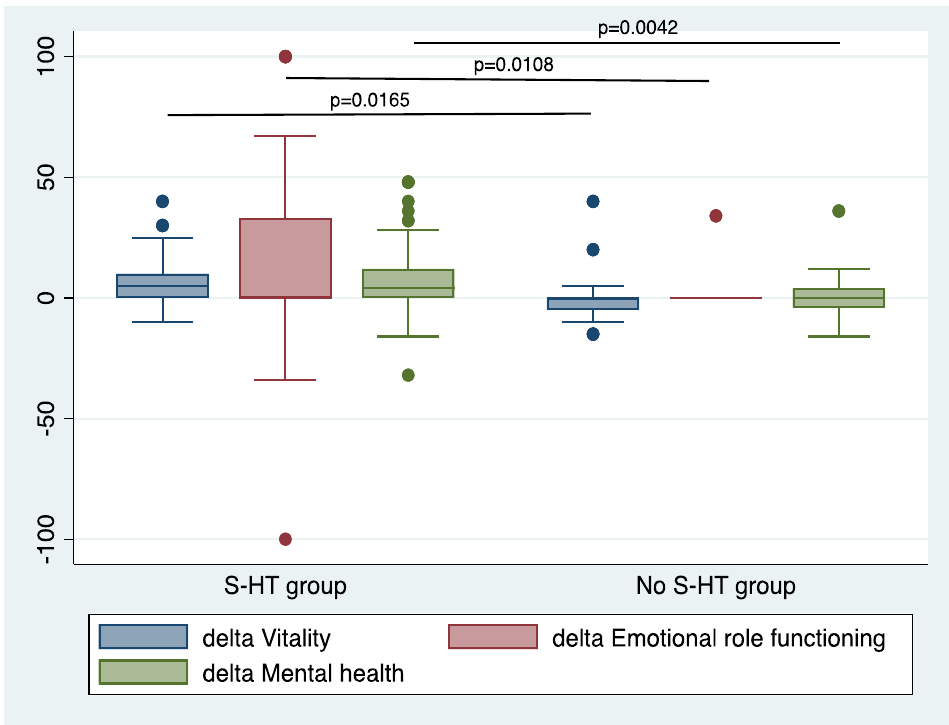
Figure 4. SF-36 Items showing significant differences in delta values between the groups. Delta value was calculated as the difference between scores at 2 weeks and scores at baseline. was calculated as the difference between scores at 2 weeks and scores at